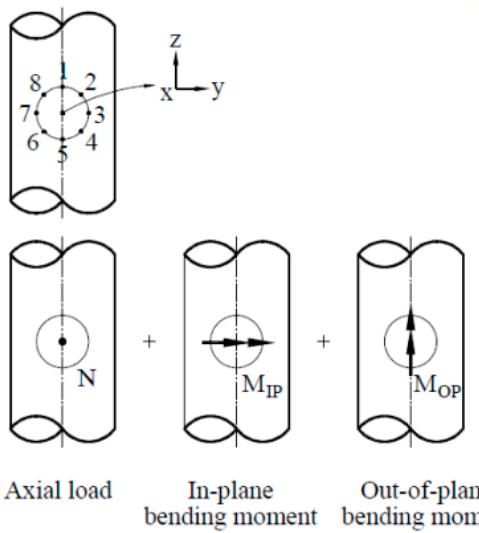
Figure 9. Uniform blade pitch angle with the designed controller.